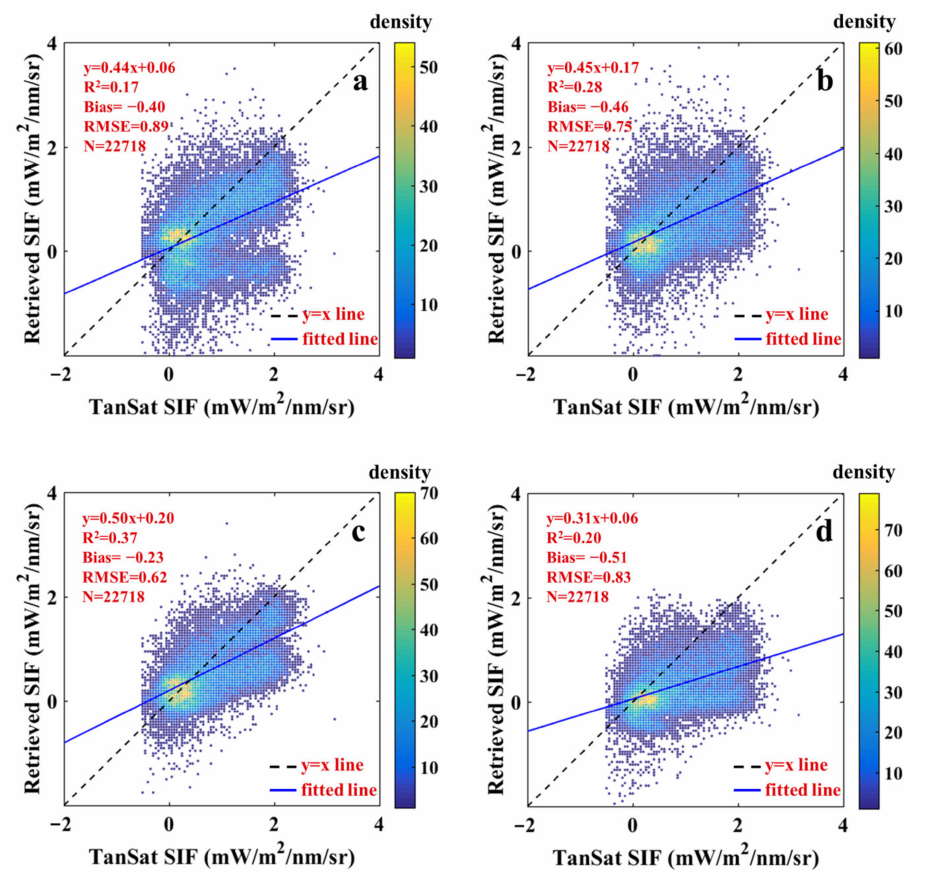
Figure 8. Scatter plot of SIF retrievals and TanSat SIF with different number of SVs: 3 ( a ), 4 ( b ), 5 ( c ), 6 ( d ). The color legend indicates the density of scattered points.